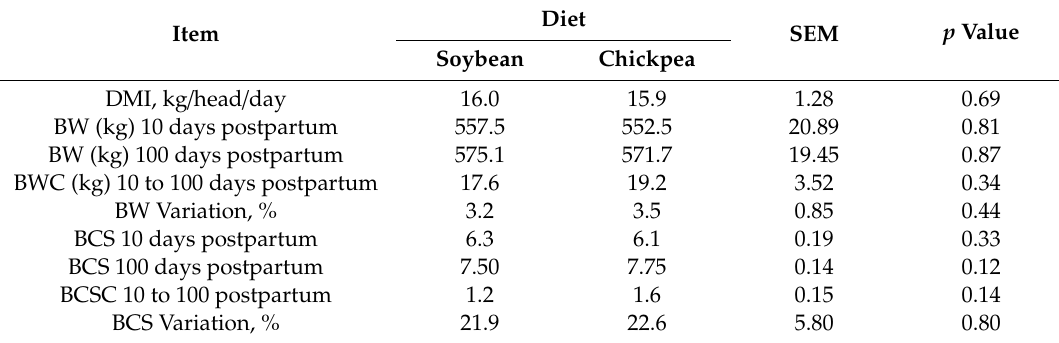
Table 3. Dry matter intake, body weight and body condition score (Least Ssquare Means) of bu ff aloes over the first 100 days of